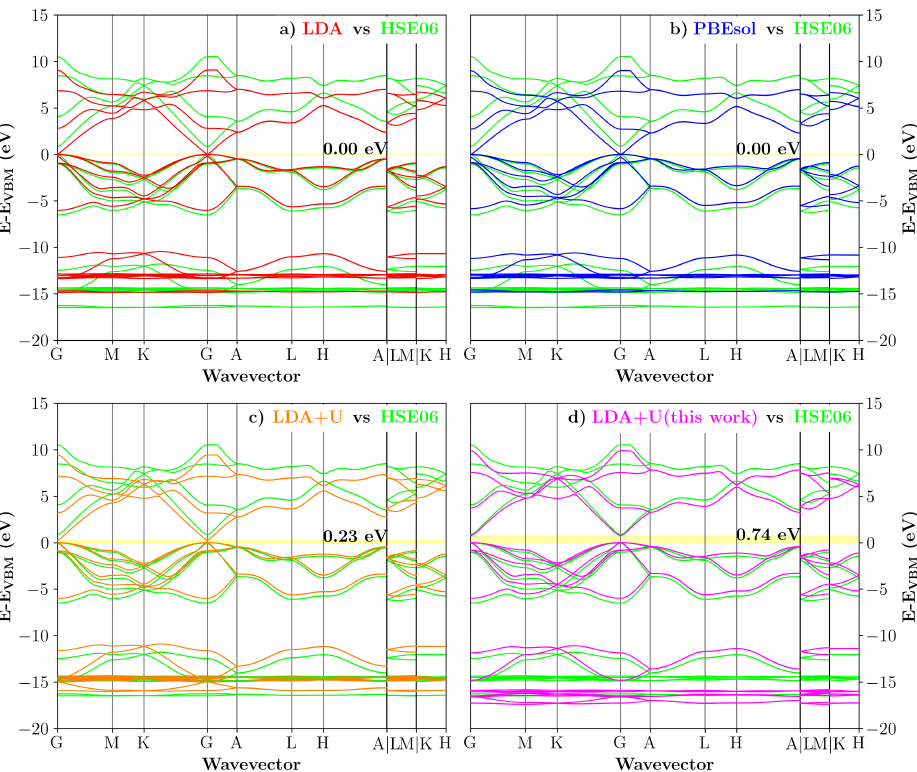
Figure 4. Hybrid DFT (HSE06) electronic band-structure of InN compared to: ( a ) LDA, ( b ) PBEsol, ( c ) LDA+U with U-parameters taken from Carvalho et al. [14], and ( d ) LDA+U with U-parameters obtained in this work. The shaded area highlights the